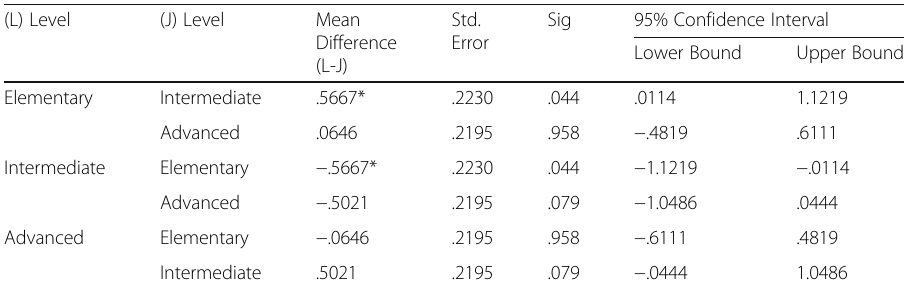
Table 3 The Results of the Scheffe Test (L) Level (J)